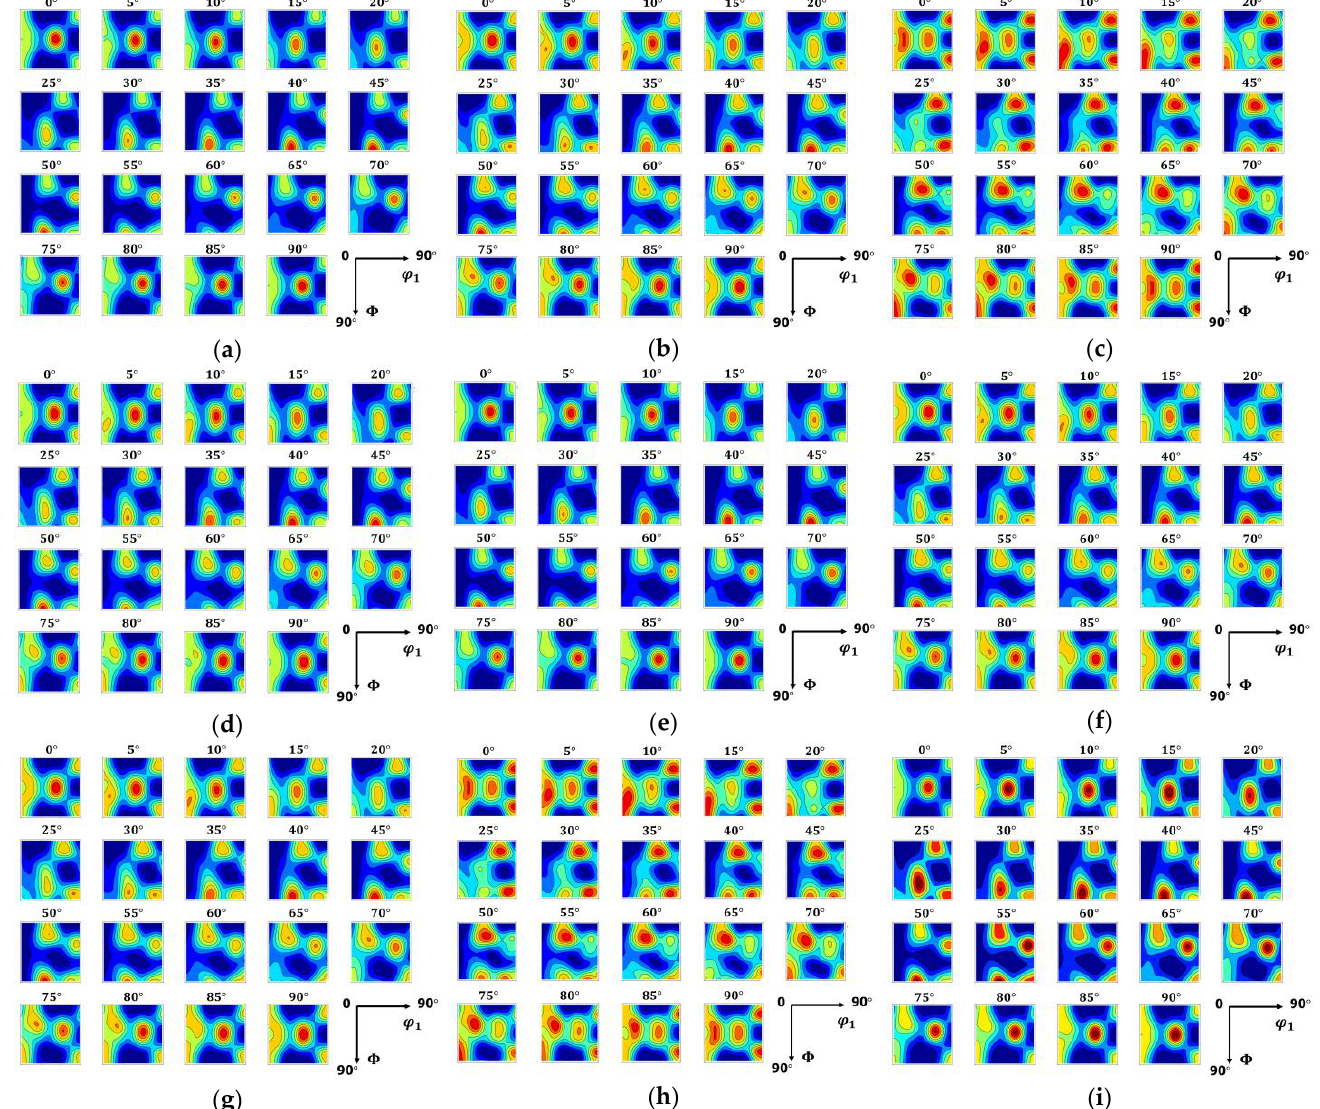
Figure 14. ODF of hot compression deformation simulated by VPSC. (The subgraph captions ( a – i ) correspond to the experimental groups (1) to (9) in Table 2, respectively).